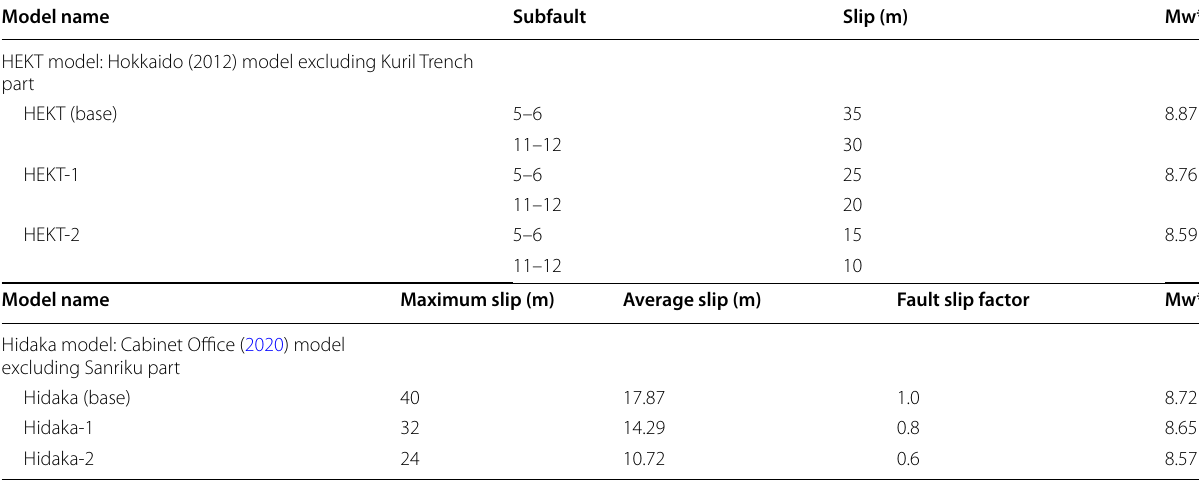
The HEKT model shows the Hokkaido (2012) model, excluding the Kuril Trench part, and the Hidaka models show the Cabinet Office (2020) model (Sanriku-Hidaka model), excluding the Sanriku part. The fault slip factor is a multiplier for the slip amount in the original Sanriku-Hidaka model *Rigidity is assumed to be 40